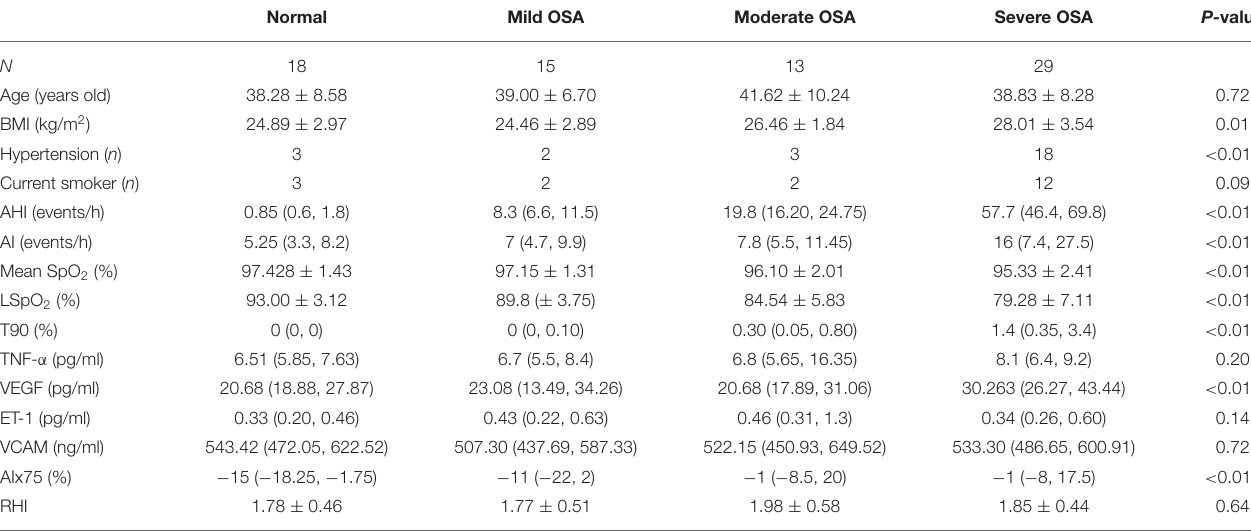
TABLE 2 | The clinical data and laboratory data in different severity obstructive sleep apnea. Normal Mild OSA Moderate OSA Severe OSA P-